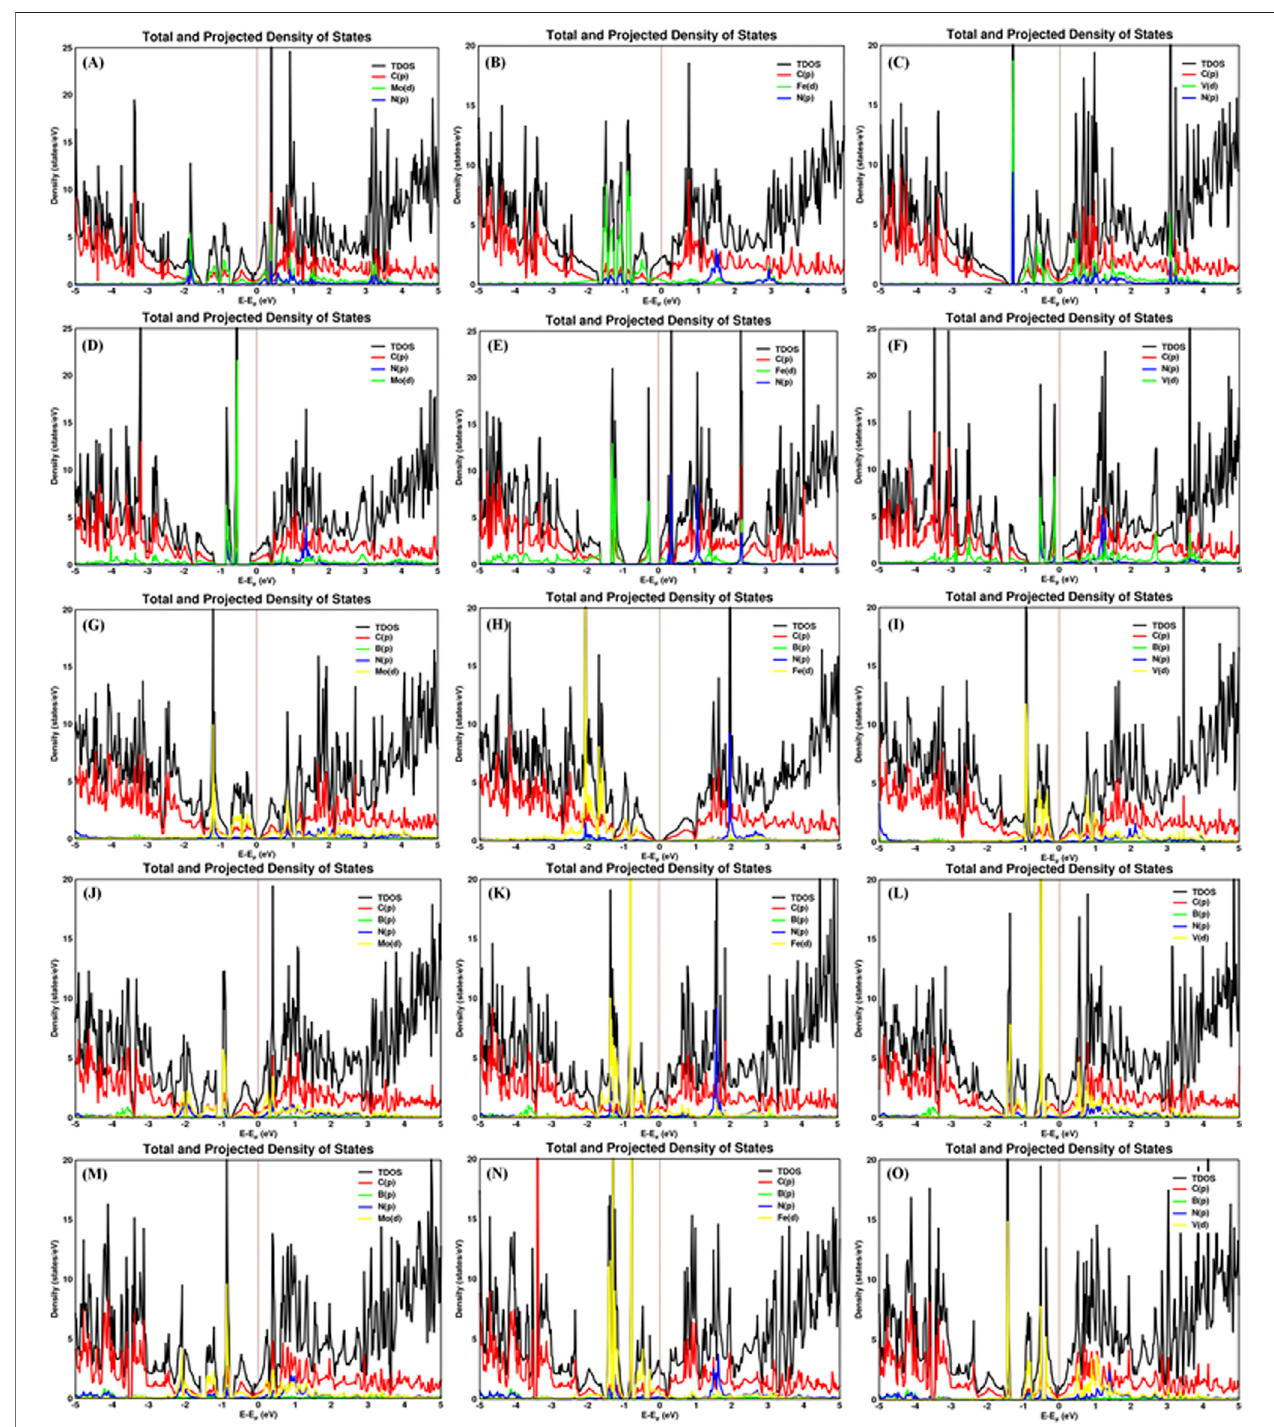
FIGURE 5 | Total and projected density of states of the N 2 molecule adsorbed on Mo, Fe, and V on various supports: (A – C) pristine graphene, (D – F) defective graphene, (G – I) BN-doped graphene, (J – L) BNC-ring graphene, and (M – O) BN-ring graphene.